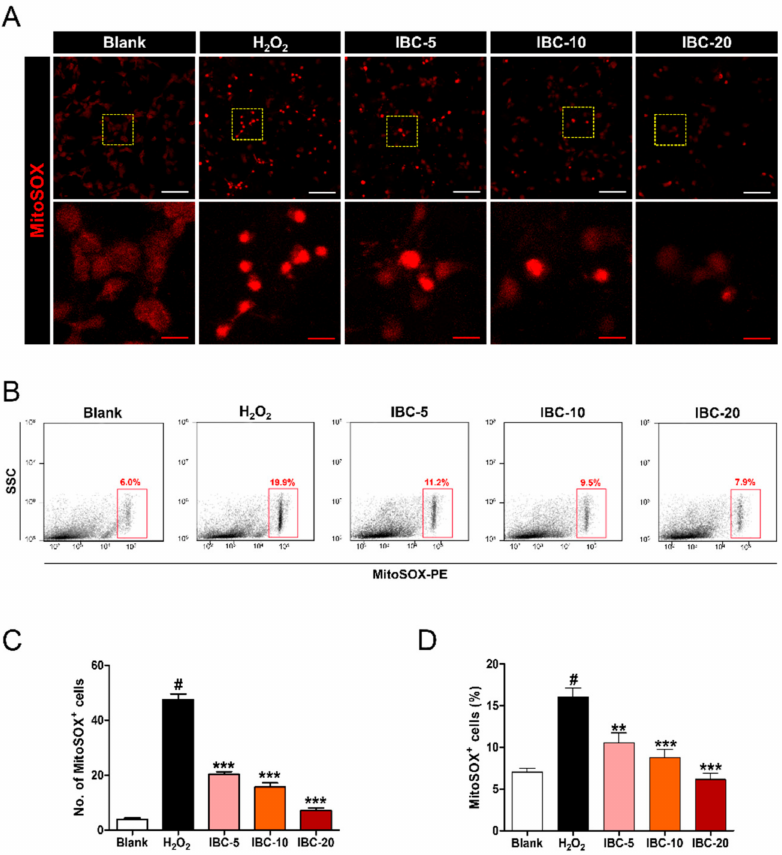
Figure 2. Effect of IBC extract on mitochondrial reactive oxygen species (ROS) production following H 2 O 2 -induced oxidative stress injury in rat primary cortical neurons. ( A ) Representative images of MitoSOX-stained neurons after IBC application in H 2 O 2 -treated neurons. White scale bar = 50 µ m, Red scale bar = 10 µ m. ( B ) Flow cytometric plots of cortical neurons stained with MitoSOX. side scattered light (SSC) ( C ) Quantification of the number of MitoSOX-labeled cells in each group (n = 9). ( D ) The percentage of positive cells for MitoSOX from flow cytometric immunofluorescence (n = 5). Data are expressed as the means ± SEM. Significant differences indicated as # p < 0.001 compared vs. the blank group, ** p < 0.01 and *** p < 0.001 vs. the H 2 O 2 group were analyzed via one-way ANOVA with Tukey’s post hoc